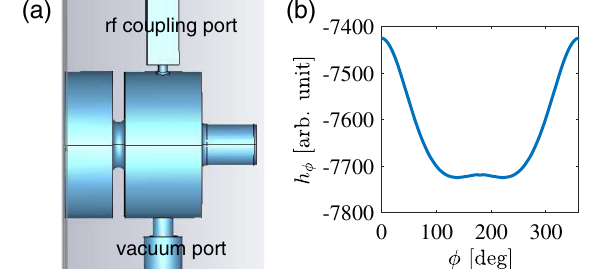
FIG. 2. The drive gun at the AWA. (a) 3D model in CST Microwave Studio; (b) Azimuthal magnetic field h ϕ along the angular direction at the center of the full cell with a 15 mm radius. A Fourier analysis shows that the quadrupole strength with respect to the monopole one is 7 . 2 × 10 − 3 , which is much larger than the LCLS gun ( 1 . 2 × 10 − 4 ) [22] and the newly designed Tsinghua gun ( 5 . 6 × 10 − 5 )